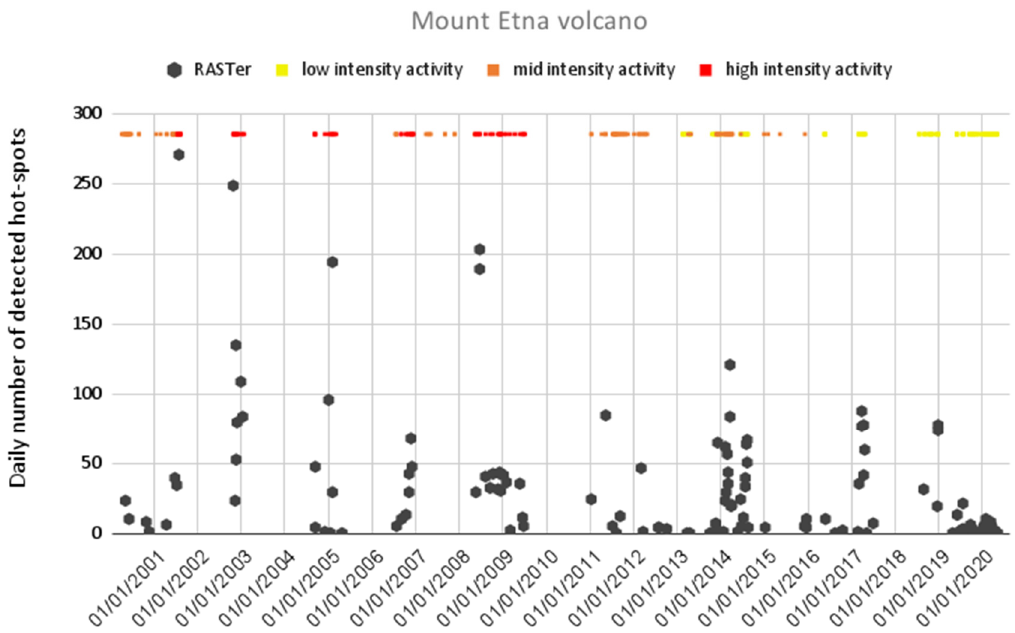
Figure 9. Time series of hot pixels flagged by RASTer at Mt. Etna in the period May 2000–2020 and different intensity levels of Mt. Etna thermal activity (colors from yellow to